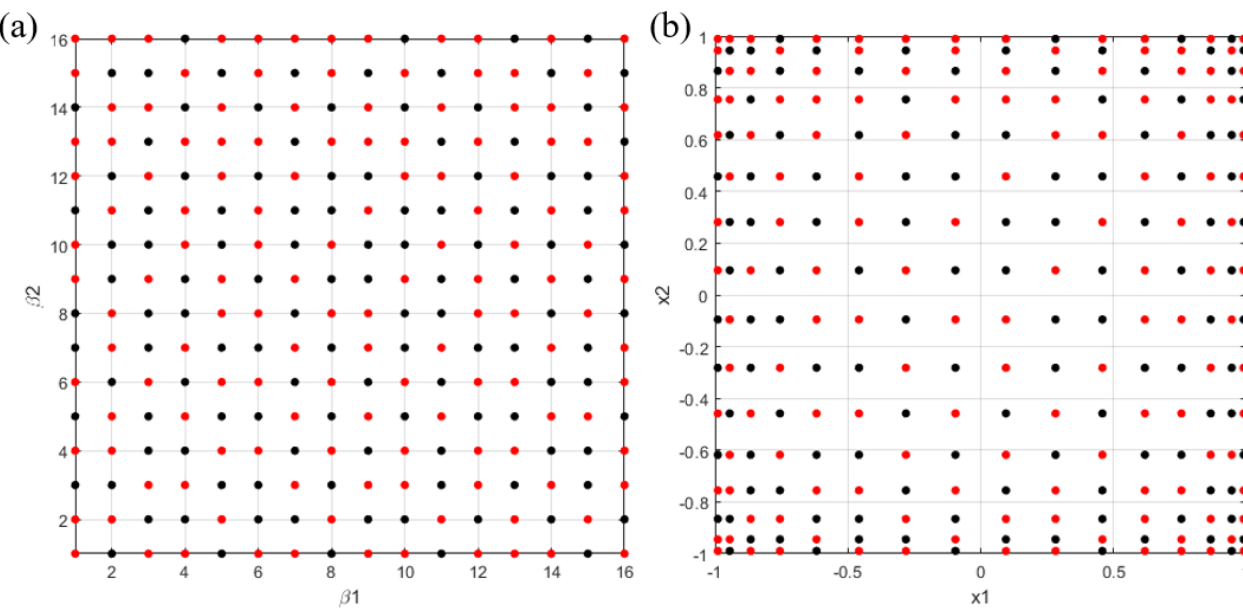
 set. Figure 1. ( a ) Candidate points in β space; ( b ) candidate points in ε